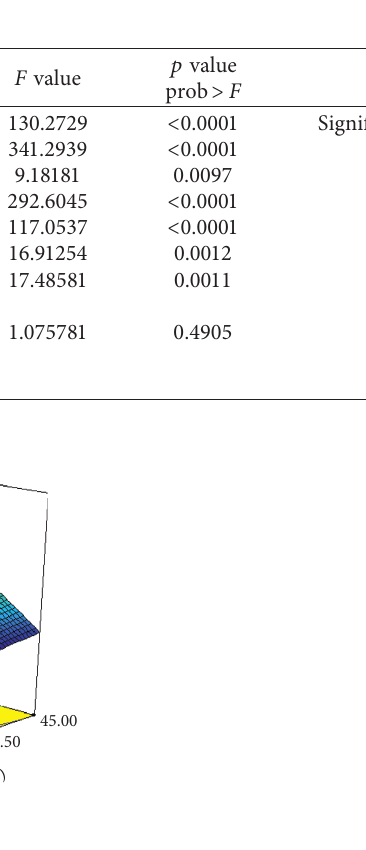
Figure 5: 3D surface plot of